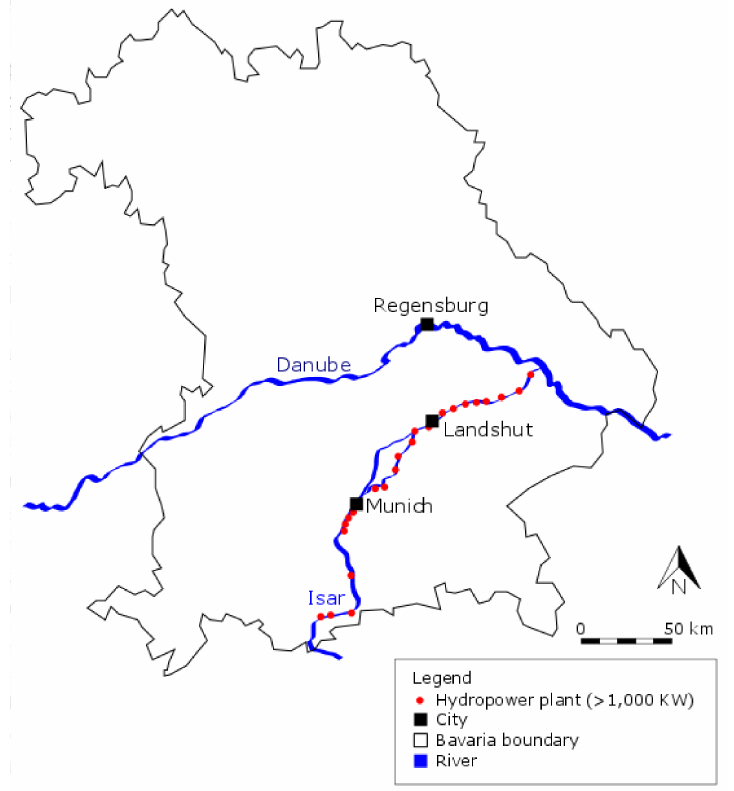
Figure 1. Map of Bavaria (Germany) with the location of the Isar River, Munich city and the hydroelectrical power plants at the